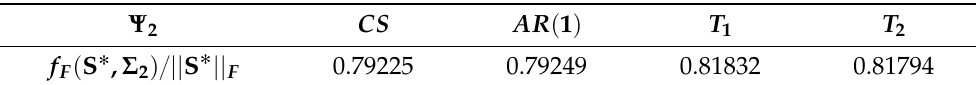
Table 3. Adjusted Frobenius norm distances between S ˚ and Σ 2 .